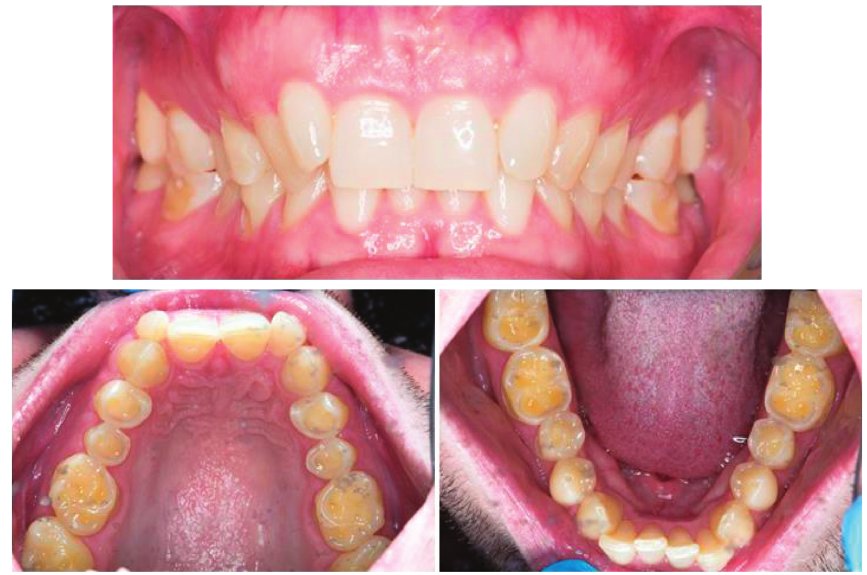
Figure 2: Clinical case two.